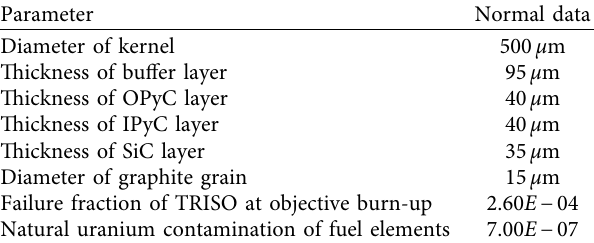
Figure 3: (a) N layers of thin spherical shell and (b) concentration distributions. Table 1: Parameters of fuel particles in HTR-PM.